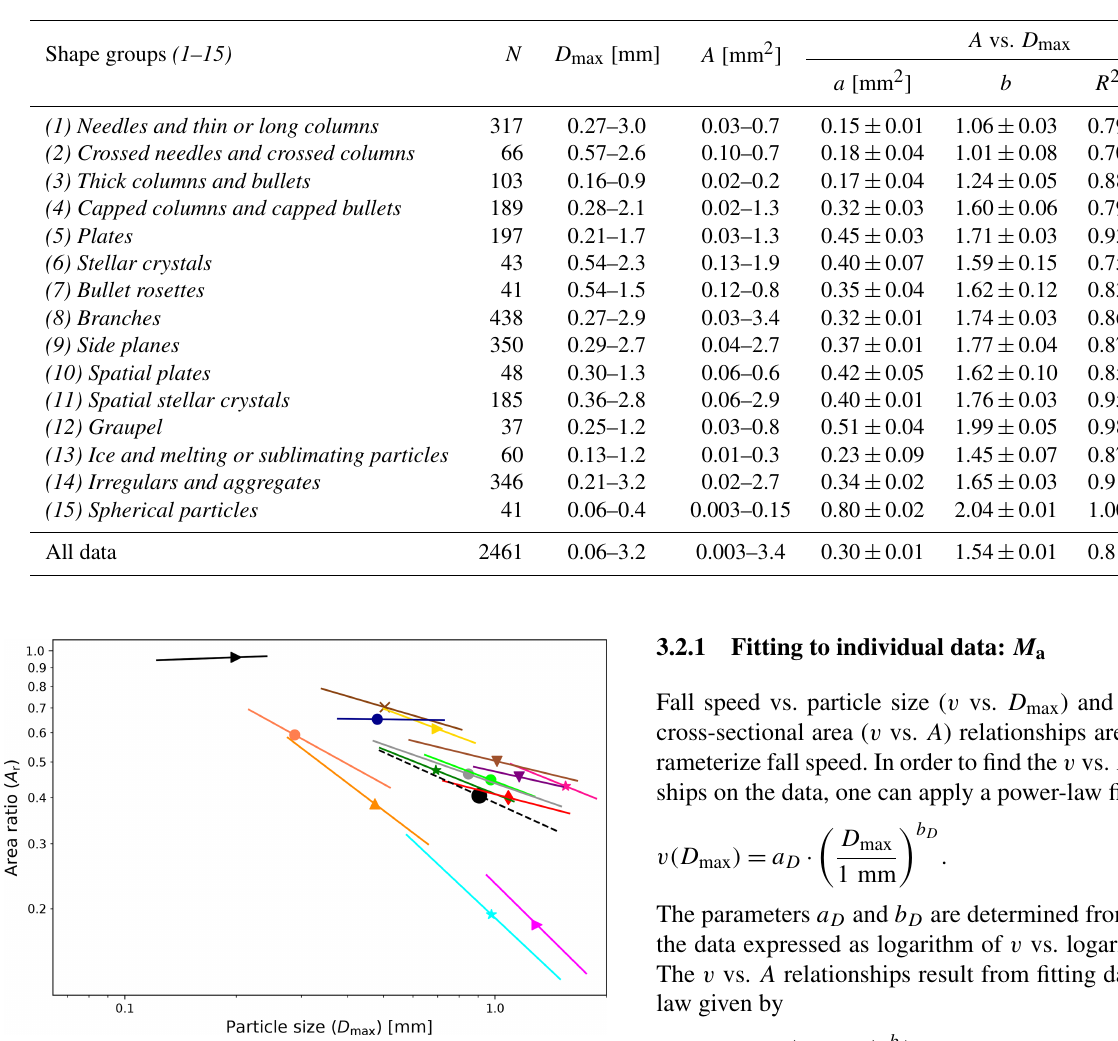
Table 1. Cross-sectional area vs. particle size ( A vs. D max ) relationships fitted to a power law given by Eq. (2) for each shape group and for all data, i.e., for all the particles regardless of shape. The number of particles N , the ranges of D max and A (min, max), the parameters a and b with their respective uncertainties, and the correlation coefficients R 2 are shown for each shape group and all data. The root-mean-square error (RMSE) values of base-10 logarithms of measured A vs. predicted A are also shown to indicate the uncertainty of these power laws. Note that RMSE values of logarithms of A r as determined from measurements using Eq. (1) vs. predicted values using Eq. (3) are the same.